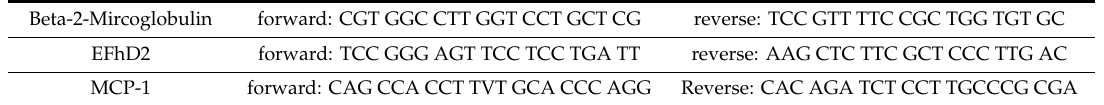
Table 3. List of porcine primers used in this